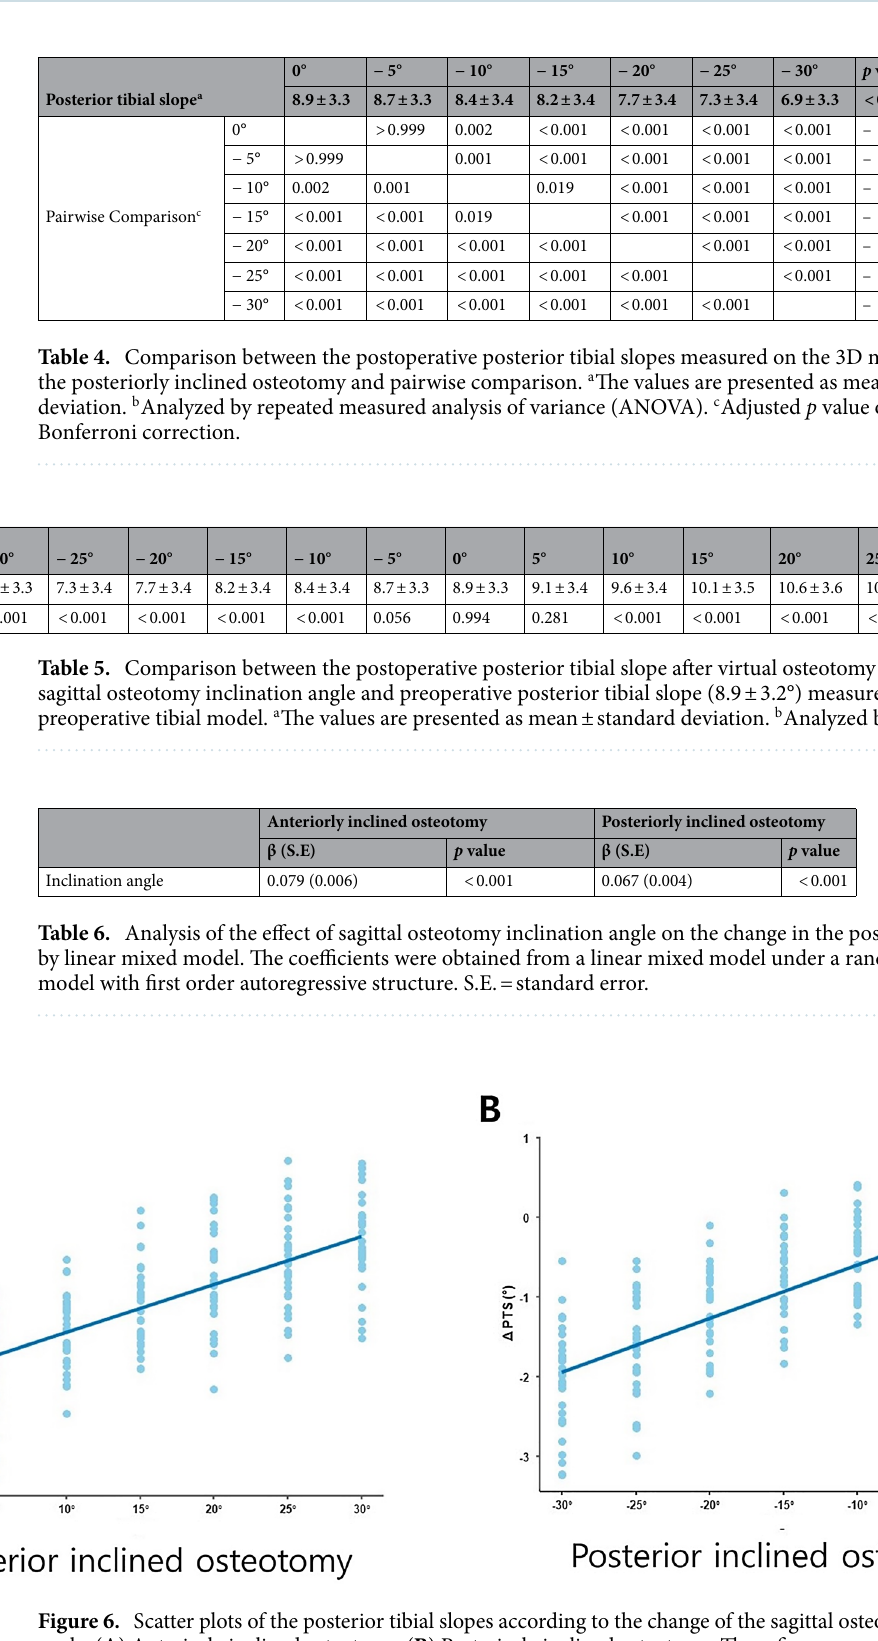
Figure 6. Scatter plots of the posterior tibial slopes according to the change of the sagittal osteotomy inclination angle. ( A ) Anteriorly inclined osteotomy. ( B ) Posteriorly inclined osteotomy. These figures were created using the R statistical software (version 3.6.2; R Foundation for Statistical Computing, Vienna,